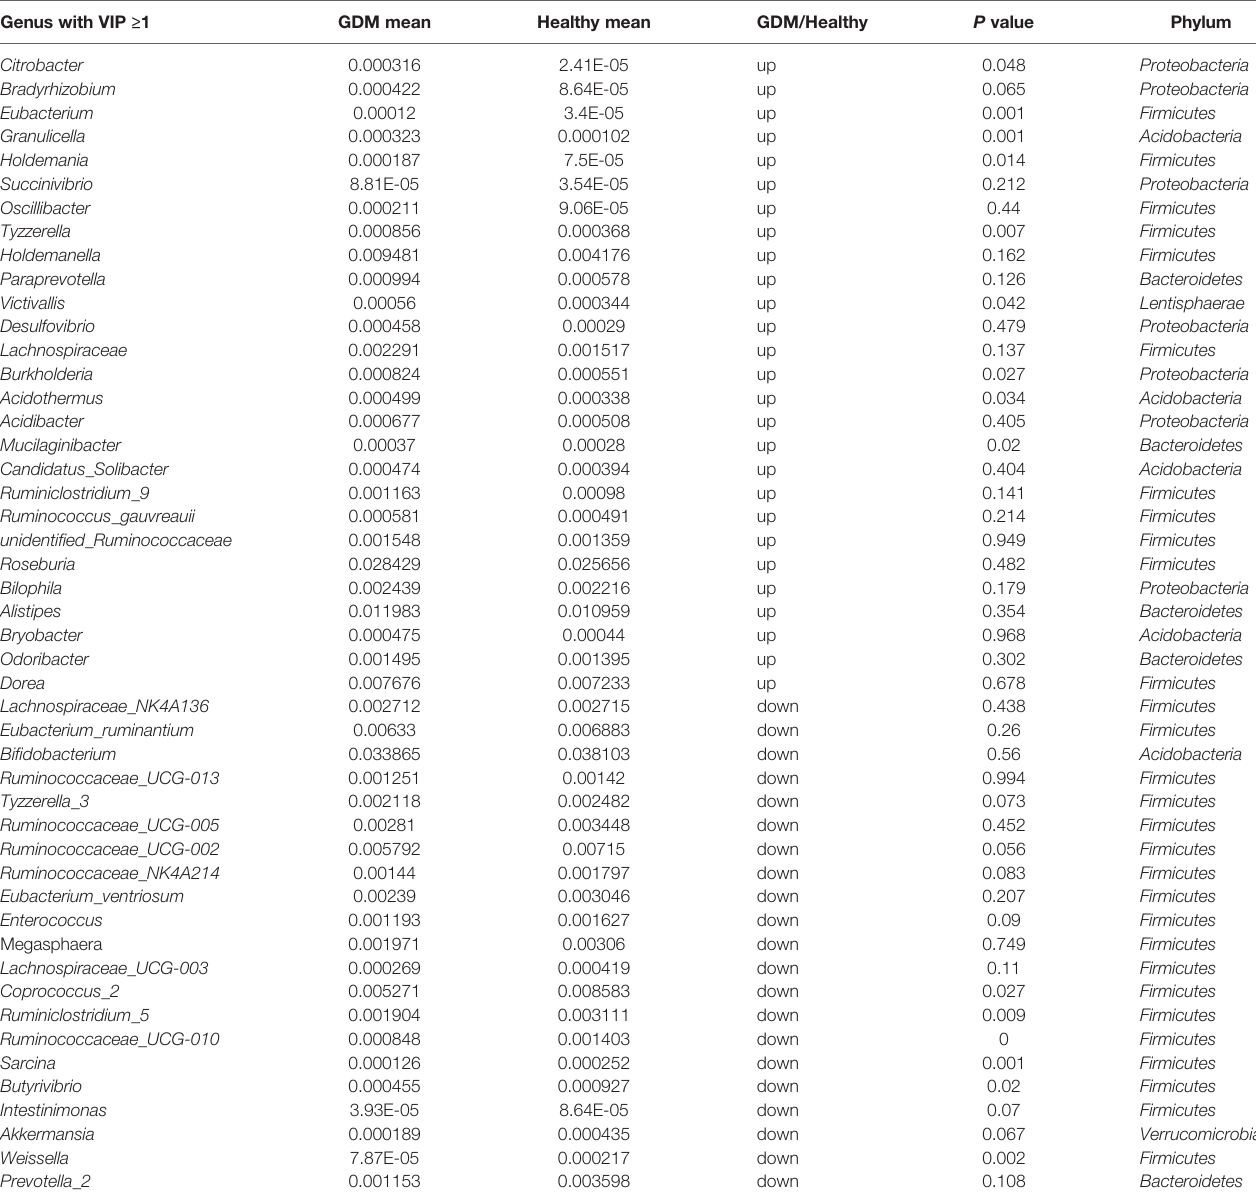
TABLE 2 | Forty-nine key genera with VIP >1 in the GDM and healthy groups. Genus with VIP ≥ 1 GDM